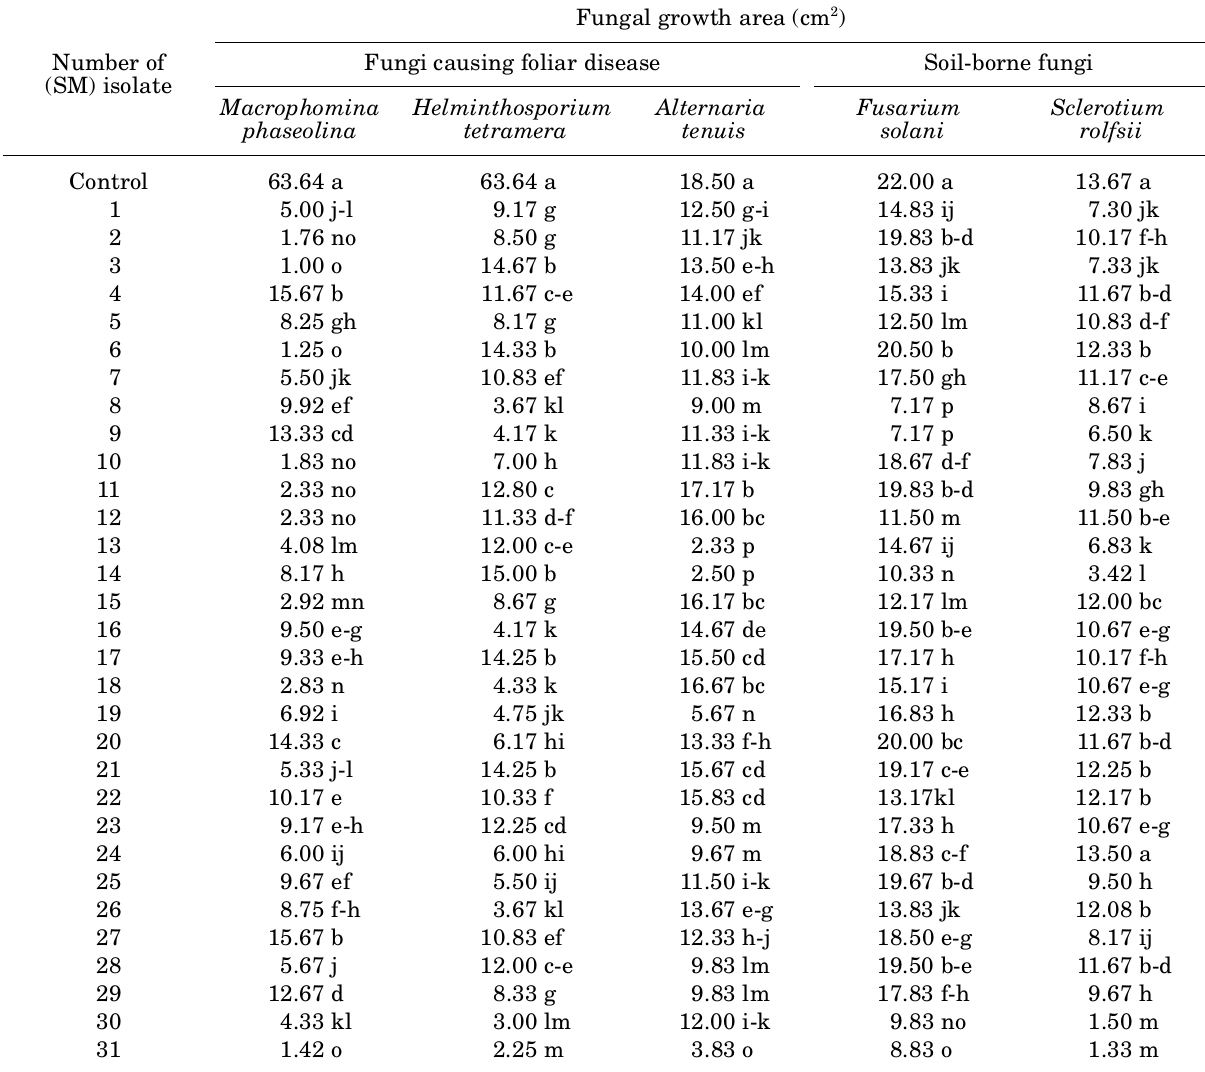
Table 1. Inhibition of fungal pathogens by 31 bacterial isolates from the phylloplane of Solanum melongena (SM). Fungal growth area (cm 2 ) Number of Fungi causing foliar